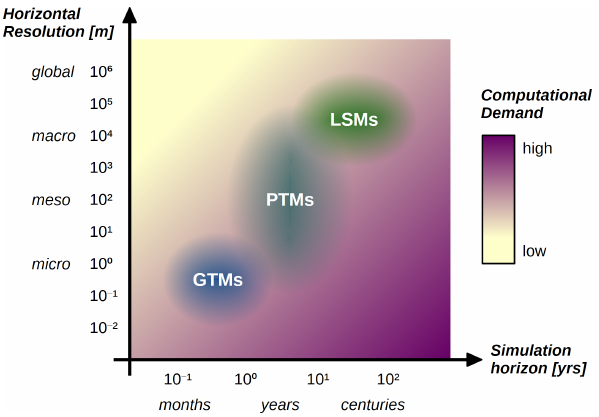
Figure 1. Classification of model classes according to their repre- sentative temporal and spatial scales. Geotechnical models (GTMs) operate on short time horizons (with a focus on the construction pe- riod), Land surface models (LSMs) focus rather on decadal to multi- centennial timescales. Process-based tiling models can fill the gap in scales between GTMs and